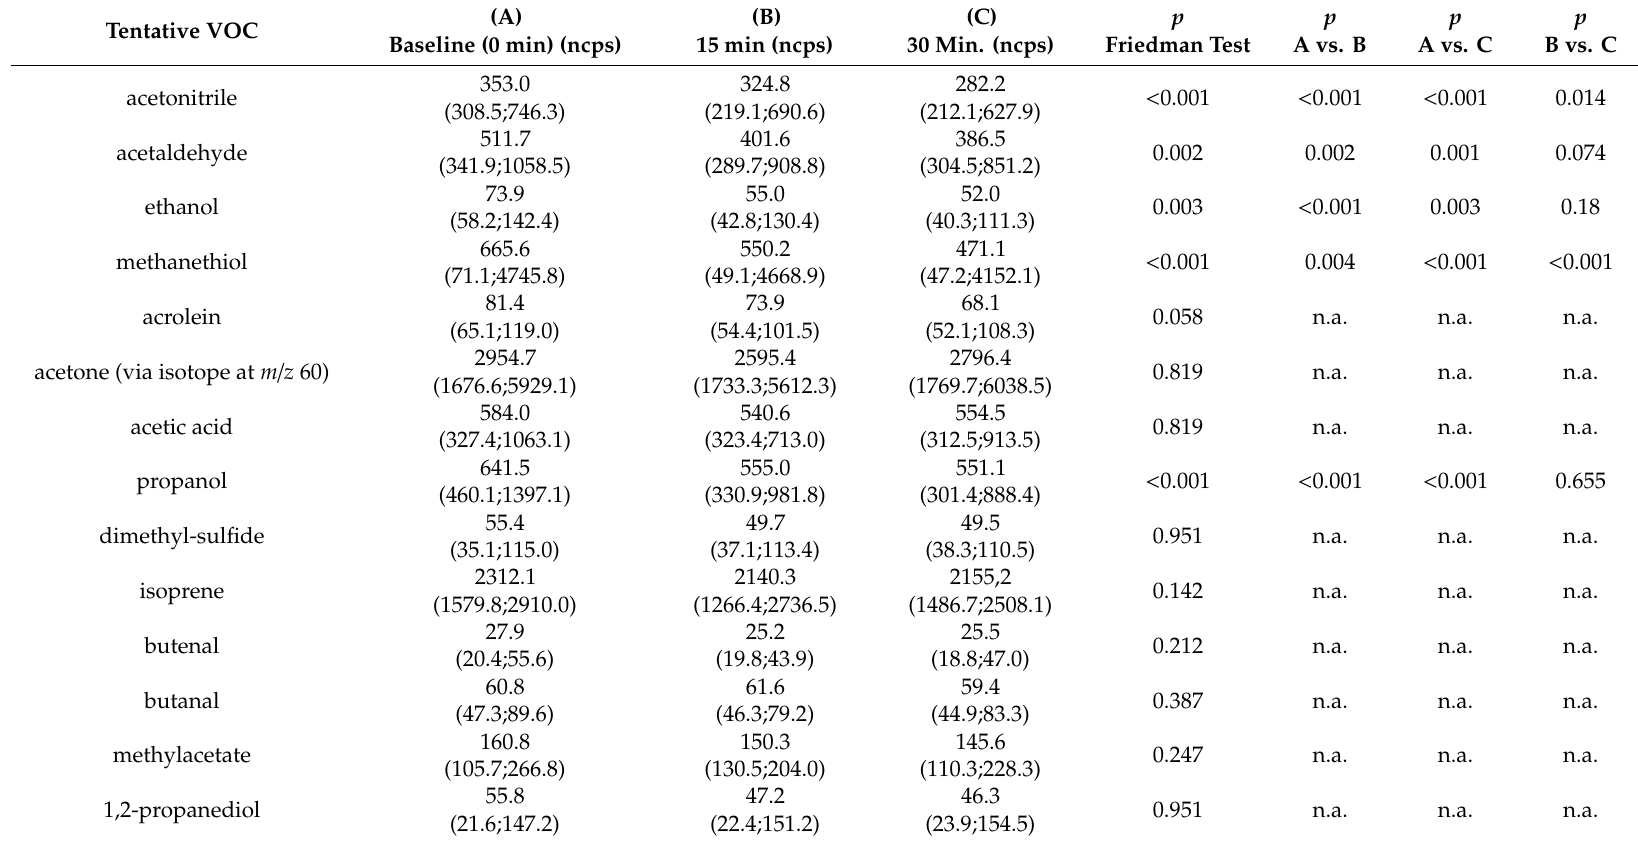
Table 2. Changes of volatile organic compounds (VOCs) over the